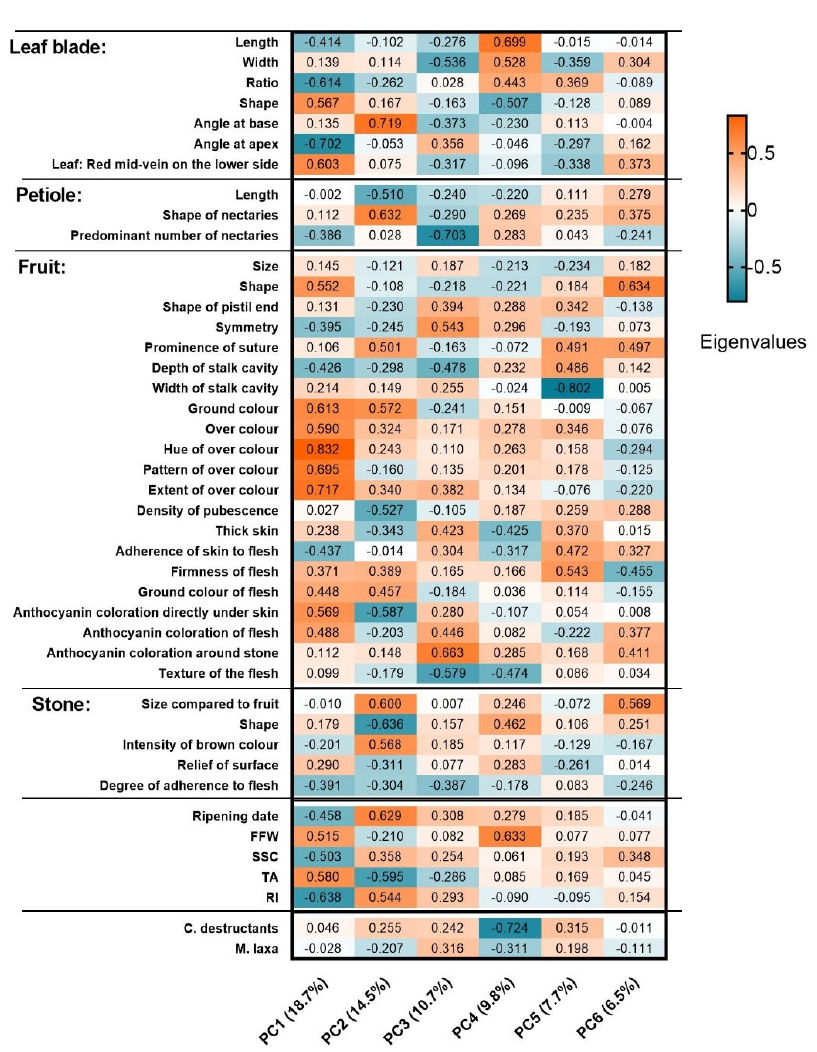
Figure 4. Eigenvalues of the first six principal component axes from the PCA on leaf, fruit and resistance to diseases traits for 18 local and foreign peach cultivars.